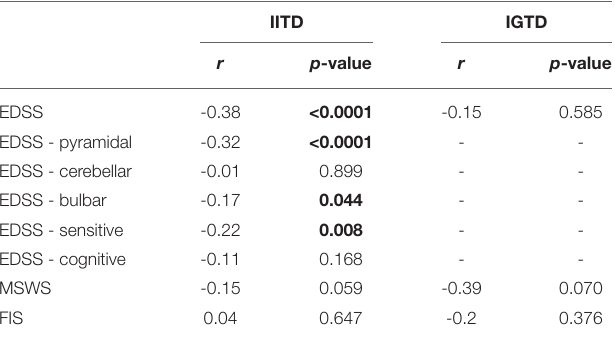
TABLE 8 | Pearson correlations of severity scores with the IITD and IGTD algorithms for pMS participants ( n = 22).